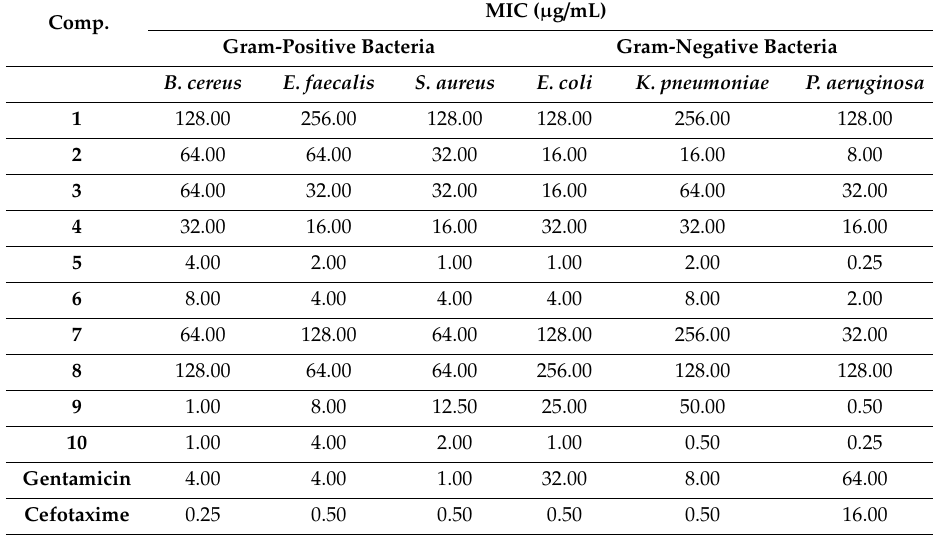
Table 2. In vitro antibacterial activities for compounds 1 – 10 expressed as minimum inhibitory concentrations (MIC; µ g / mL) a,b .